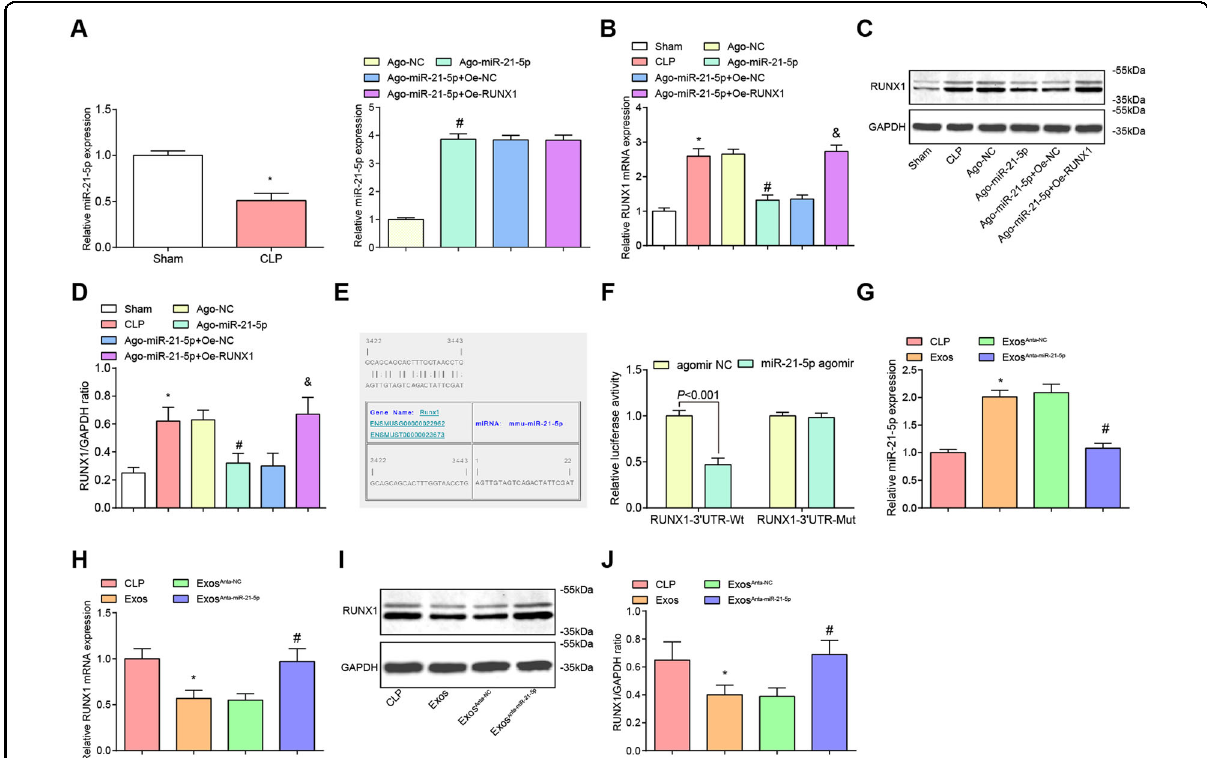
Fig. 4 miR-21-5p expression is reduced while RUNX1 expression is raised in renal tissues of CLP rats, exosomes raise miR-21-5p expression in renal tissues of CLP rats and miR-21-5p targets RUNX1. A / G The expression of miR-21-5p in renal tissues of CLP rats detected by RT-qPCR. B / H The expression of RUNX1 mRNA in renal tissues of CLP rats detected by RT-qPCR. C / I Protein band of RUNX1 in renal tissues of CLP rats. D / J The expression of RUNX1 protein in renal tissues of rats detected by western blot analysis. E The binding site of miR-21-5p and RUNX1 predicted by online software. F The target relationship between miR-21-5p and RUNX1 veri fi ed by dual-luciferase reporter gene assay. A – D , n = 10. * P < 0.05 vs. the sham group. # P < 0.05 vs. the Ago-NC group. & P < 0.05 vs. the Ago-miR-21-5p + Oe-NC group. G – J n = 10. * P < 0.05 vs. the CLP group. # P < 0.05 vs. the Exos Anta-NC group. F N = 3. Measurement data were depicted as mean ± standard